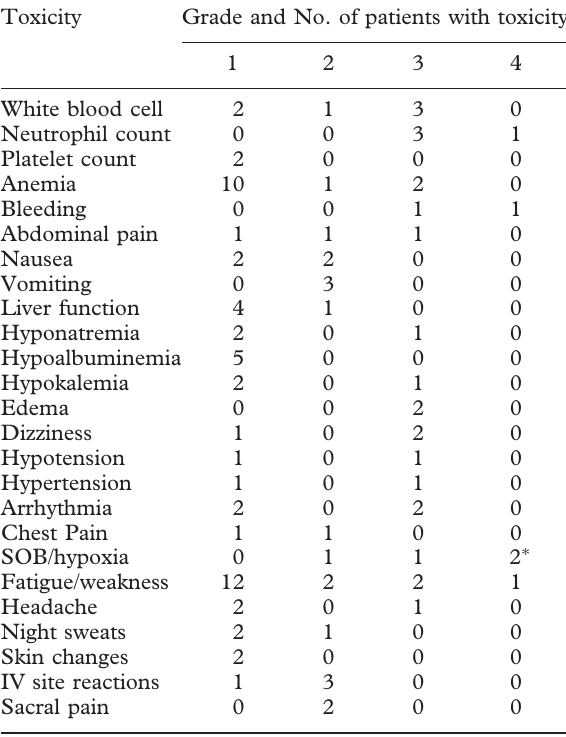
Table 2. Summary of toxicity using the Common Toxicity Criteria version 2.0: worst grade for all cycles of treatment Toxicity Grade and No. of patients with toxicity